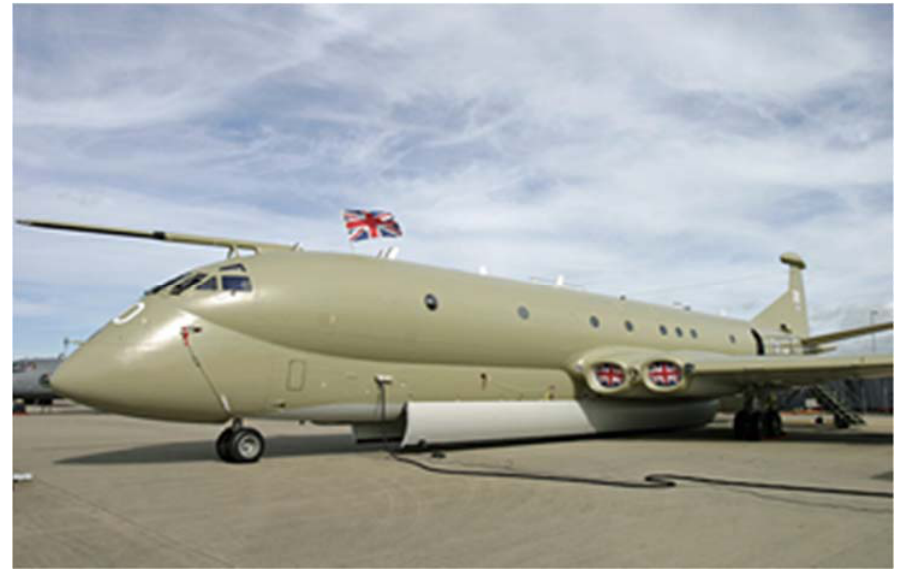
Figure 4. RAF NIMROD XV230 aircraft (from [23]).